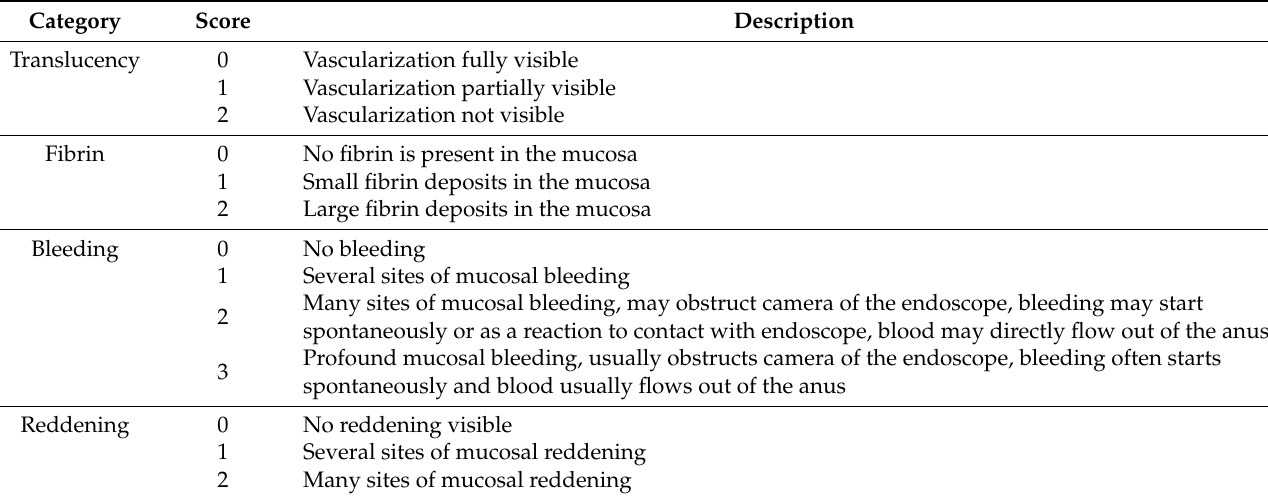
Table 1. Endoscopy scoring system. The table describes score values of each examined